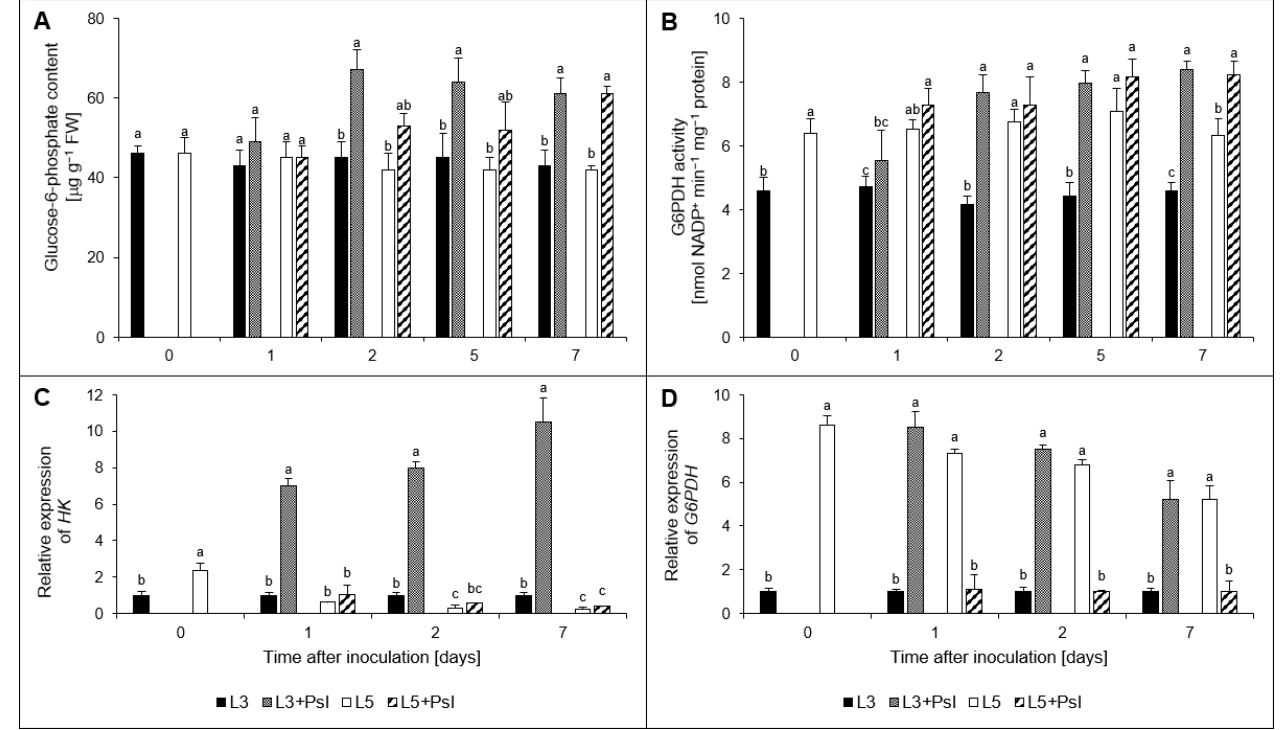
Figure 4. Infection-induced changes in ( A ) glucose-6-phosphate content, ( B ) glucose-6-phosphate dehydrogenase (G6PDH) activity, and the relative expression of ( C ) hexokinase ( HK ) and ( D ) glucose-6-phosphate dehydrogenase ( G6PDH ) genes in cucumber leaves. Values are means of four replicates (±SD). Different letters (a–c) indicate significant ( p ≤ 0.05) differences between experimental variants at a given time point.